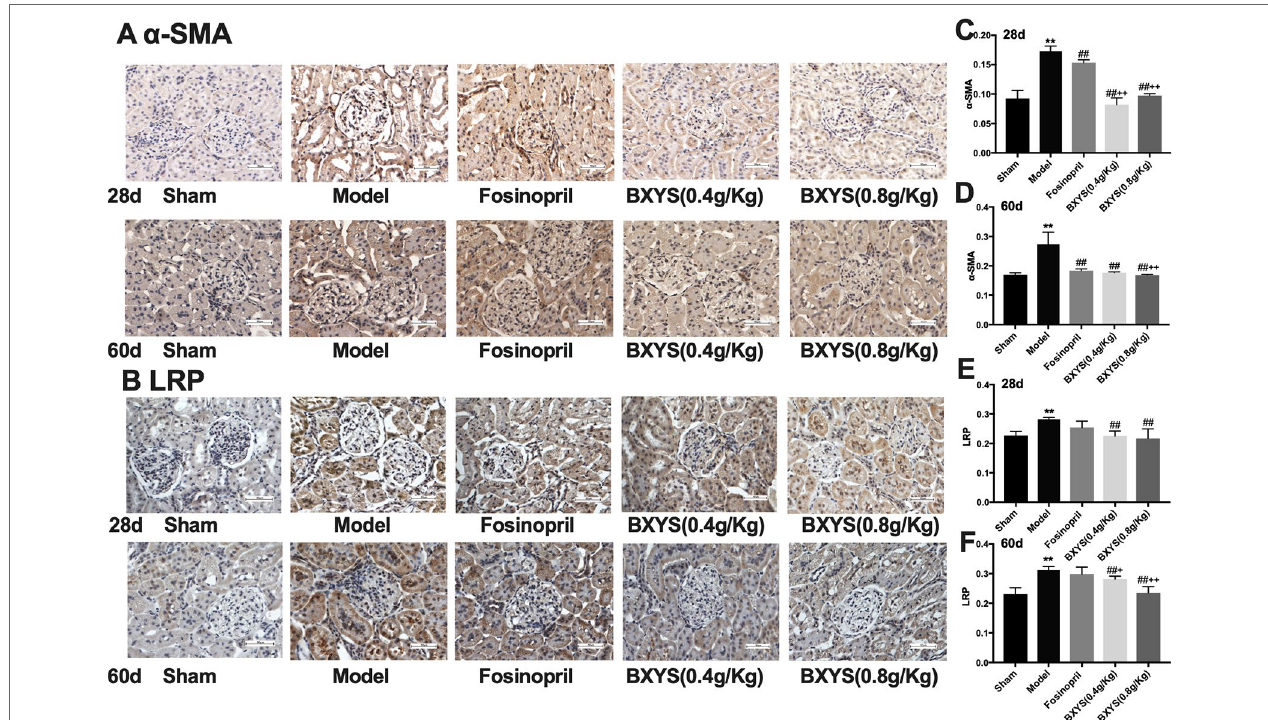
FIGURE 6 | Determination of α -SMA and LRP expression in kidney tissue after 28 days and 60 days of drug administration. Sham, sham group; Model, model group; Fosinopril, fosinopril group; BXYS (0.4 g/kg), Buxin Yishen 0.4 g/kg treated group; BXYS (0.8 g/kg), Buxin Yishen 0.8 g/kg treated group. **P <0.01 vs. sham group. ## P < 0.01 vs. model group. + P < 0.05, ++ P < 0.01 vs. fosinopril group. (A) Alpha smooth muscle Actin ( α -SMA) expression in kidney tissue (×400 magnification). (B) Low density lipoprotein receptor-related protein (LRP) expression in kidney tissue (×400 magnification). ( C and D ) Quantitative analysis of α -SMA expression after 28 days and 60 days. ( E and F ) Quantitative analysis of LRP expression after 28 days and 60 days.